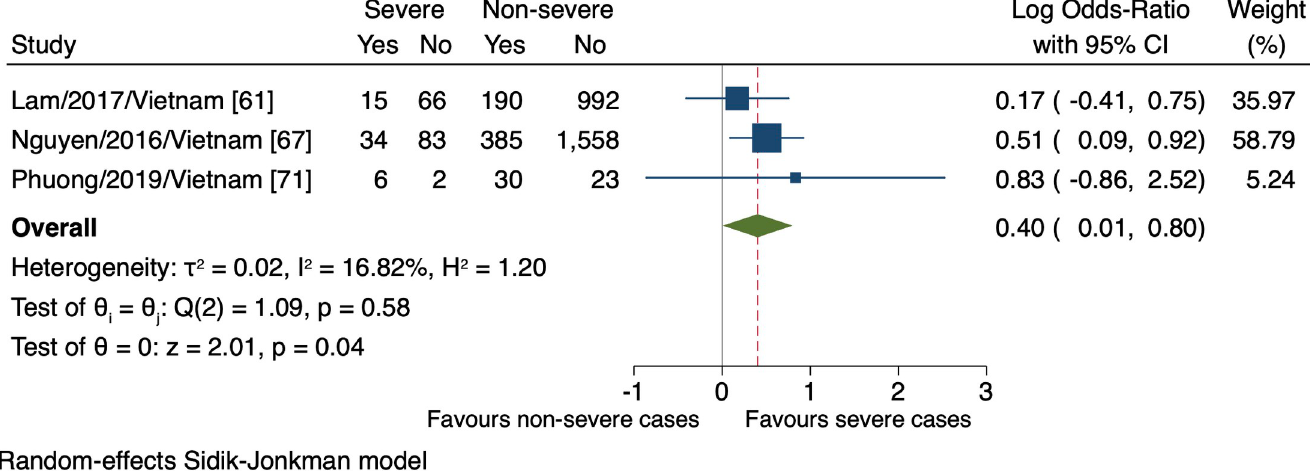
PLOS NeglectedTropical Diseases | https://doi.org/10.1371/journal.pntd.0009808 October 5,